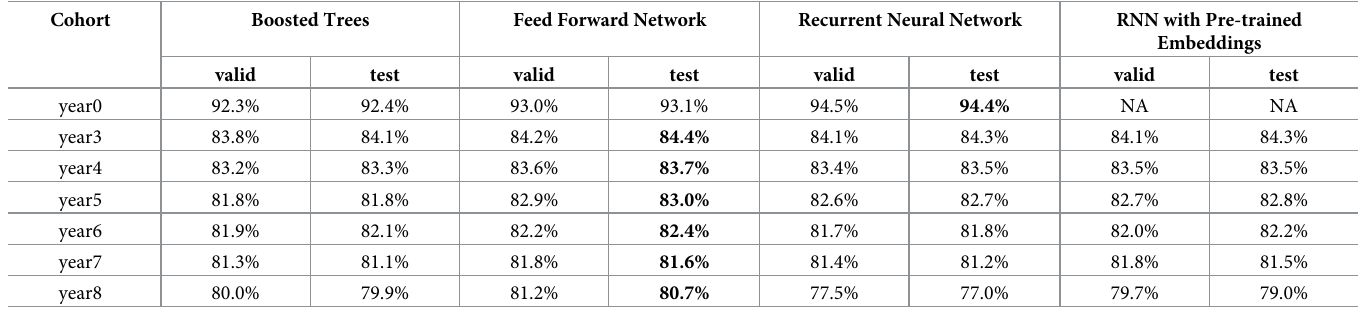
Table 2. Area under the curve for validation and test cohorts using different models. Cohort Boosted